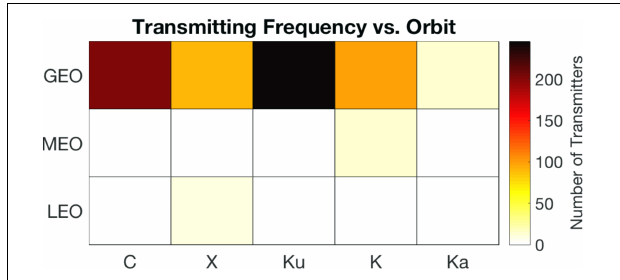
FIGURE 9 | Number of currently operational spaceborne transmitters between C- and Ka-band